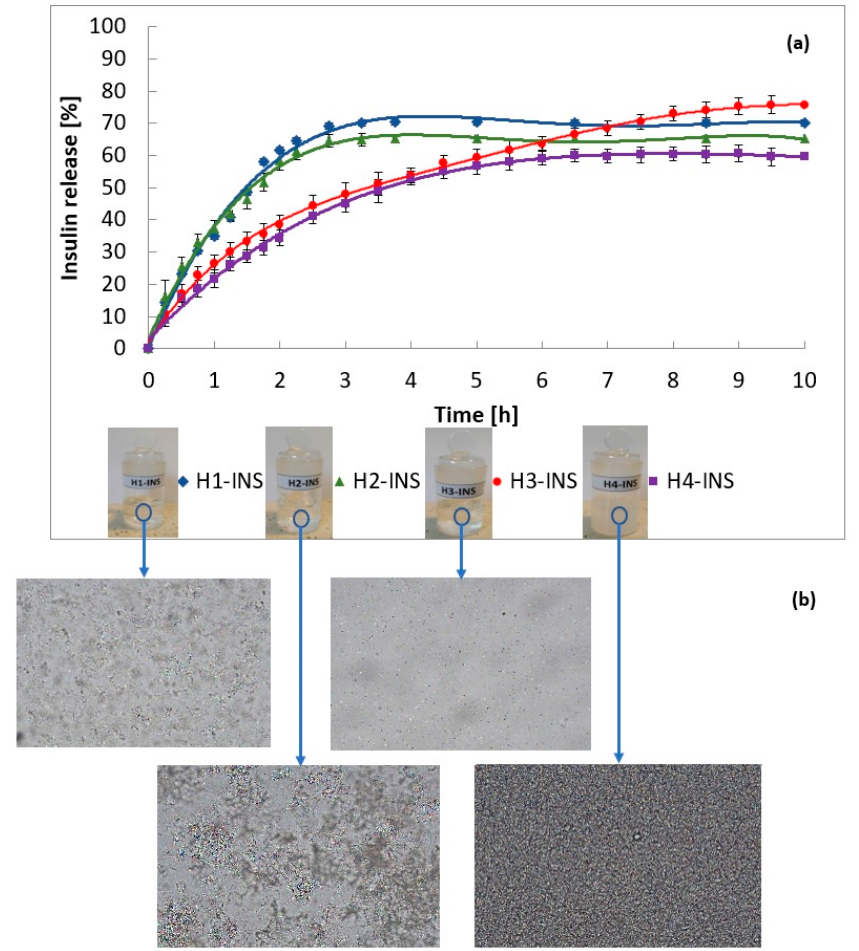
Figure 4. ( a ) Graphical comparison of profiles of insulin release from the tested hydrogels. Each value represents the mean ± SD ( n = 18). ( b ) Microscope image of hydrogels (100 × ; polarizing microscope LAB 40, Opta-Tech, Warszawa, Poland).